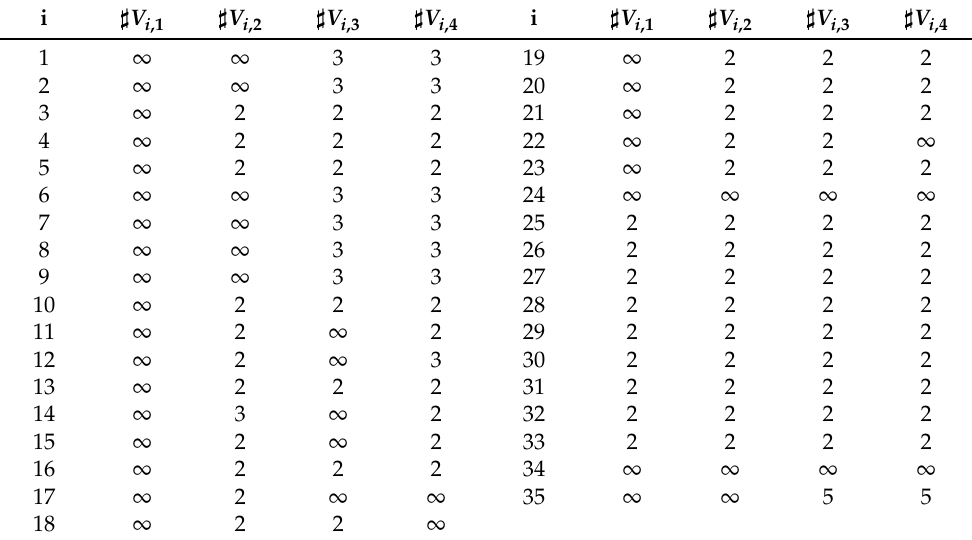
Table 2. Cardinalities ( (cid:93) V i , s ) of the affine algebraic set V Q ( I ( P 90,90; s ( L 4. i ))) , for all positive integers i ≤ 35 and s ≤